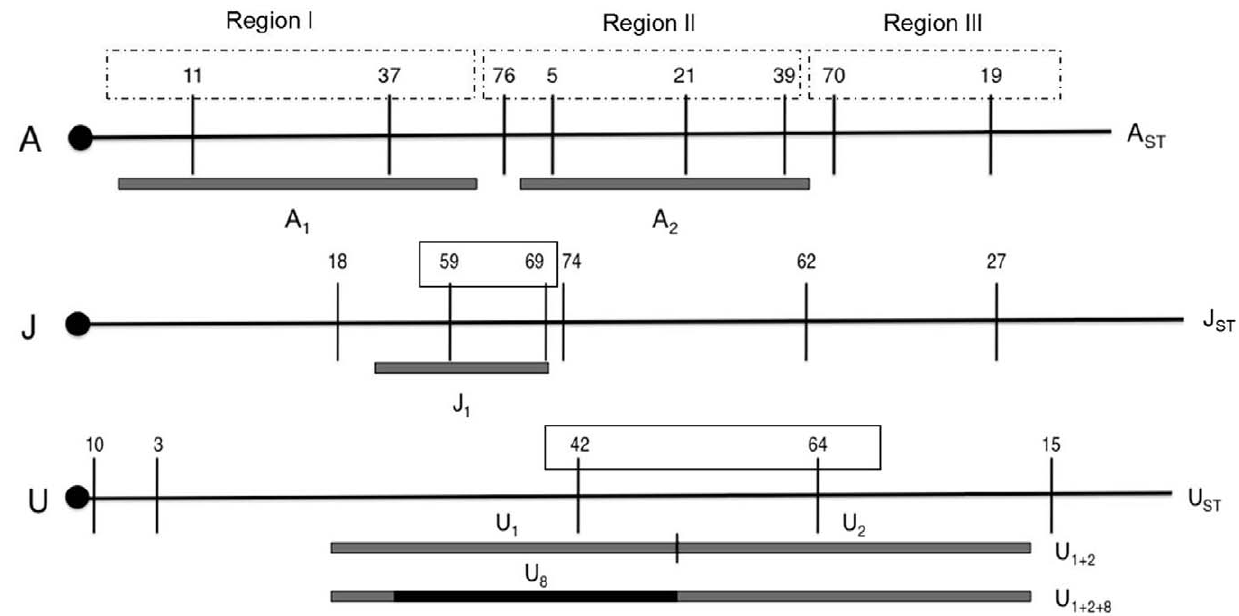
Figure 2. Schematic representation of the microsatellite loci cytological location in chromosomes A, J, and U of Drosophila subobscura in relation to the studied arrangements. The centromere on the left is represented by a black circle. Boxes indicate loci located inside inversions (or inside the three regions defined in chromosome A).